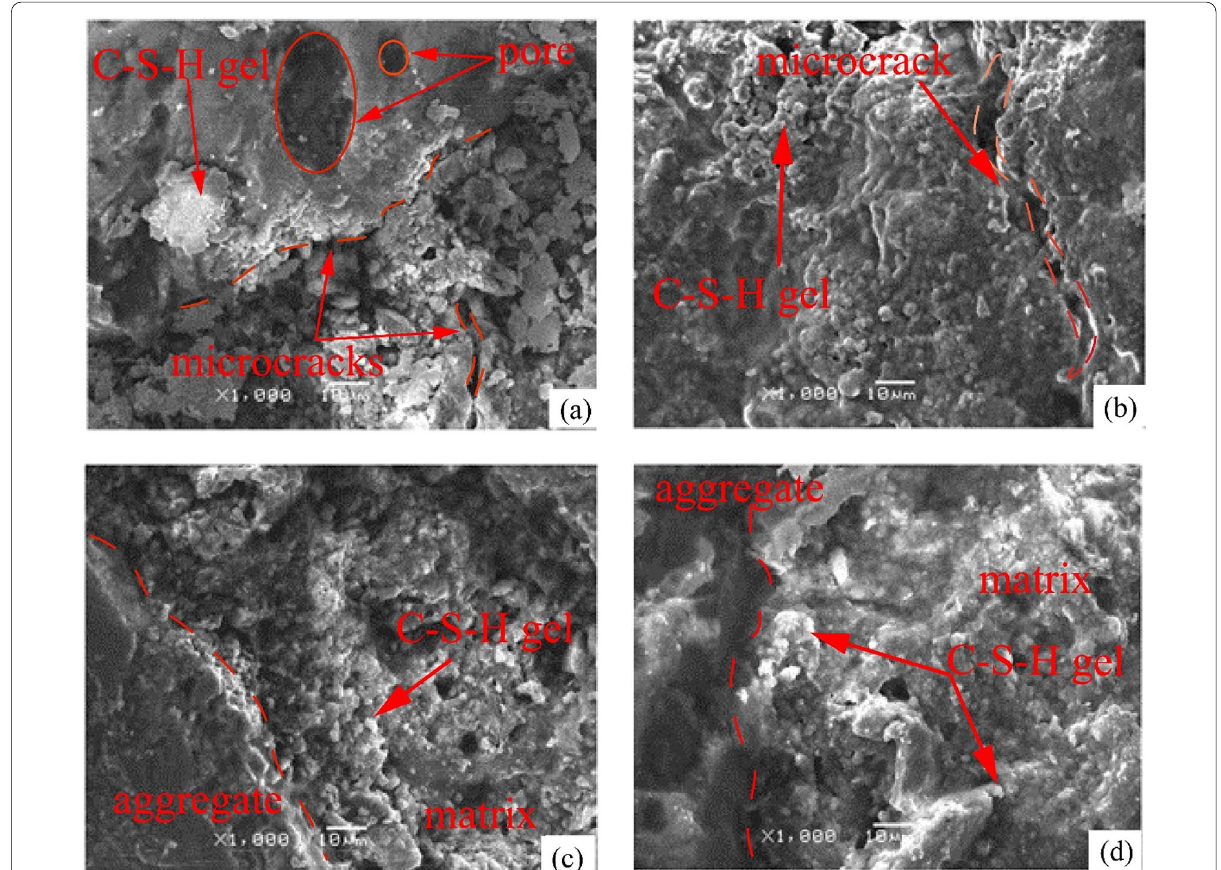
Fig. 11 SEM micrographs of CSM samples with a 5% cement dosage under different mixing methods. a CM0; b VM1.0; c VM2.0; d